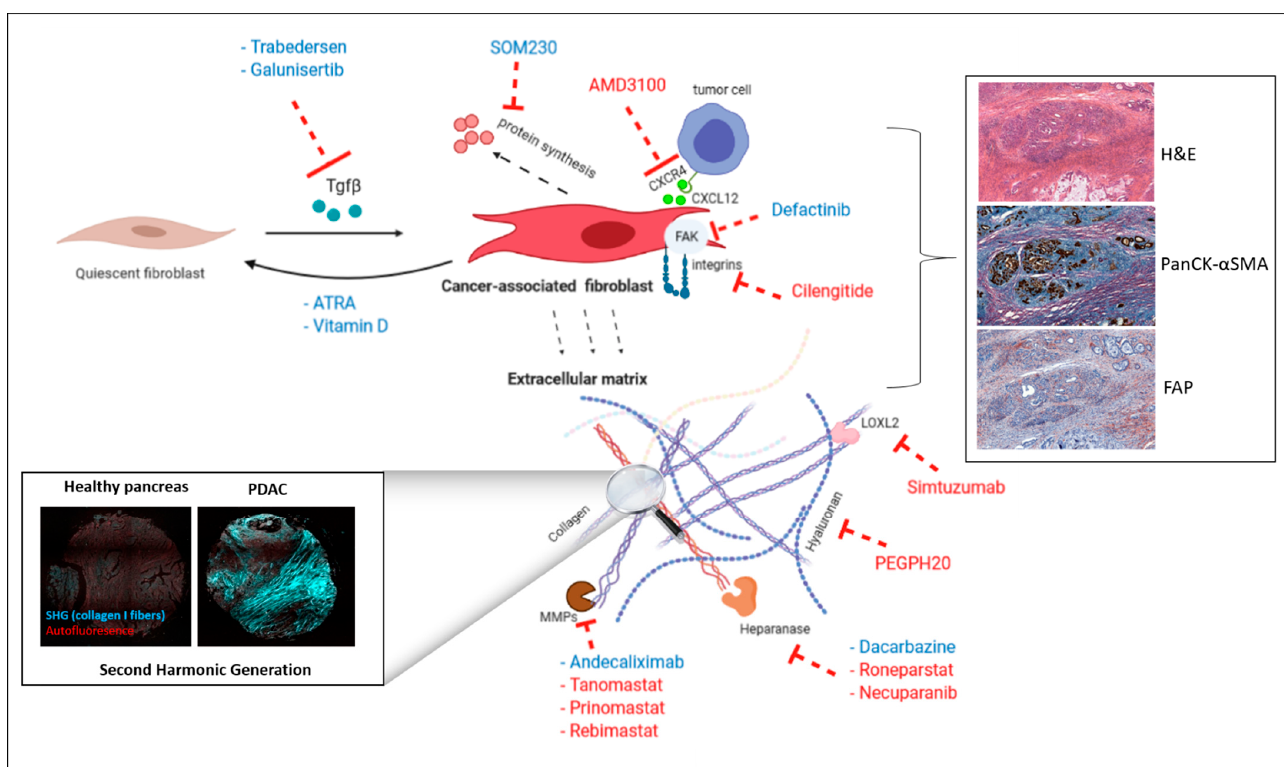
Figure 2. Schematic of stroma key events involved in tumor progression and under investigation in clinical trials comple- mented by representative images of the typical organization of ECM, CAFs and tumor cells within PDAC samples. Blue: ongoing clinical trials; red: drugs that failed in clinical trials; ATRA: all-trans retinoic acid; MMPs: matrix metalloproteinases. Representative images of H&E (allowing the visualization of ECM rich areas) and IHC on human PDAC samples showing CAFs (positive for FAP- α : fibroblast activation protein and/or α SMA: alpha smooth muscle actin), and epithelial cells (positive for PanCK: pan cytokeratin). Courtesy of Dr Jérome Cros (Department of Pathology; Hospital Bichat-Beaujon, Paris, France). Representatives images of Second harmonic generation microscopy on tissue microarray from healthy pancreas or PDAC patients showing collagen fibers.